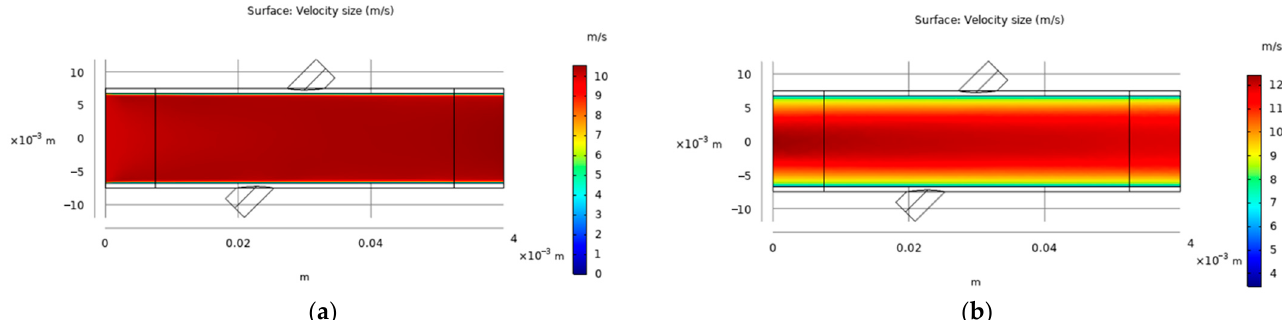
Figure 2. ( a ) Background average flow amplitude of laminar fluid state; ( b ) Background average flow amplitude of turbulent fluid